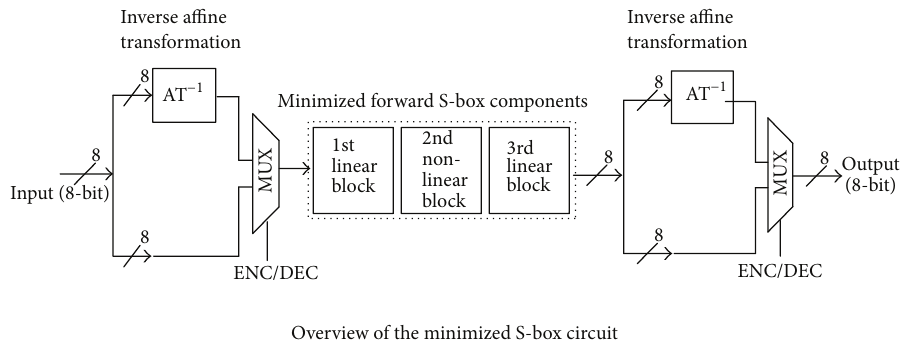
Figure 11: The illustration of the placement of the additional inverse-affine blocks in the Boyar’s S-box.